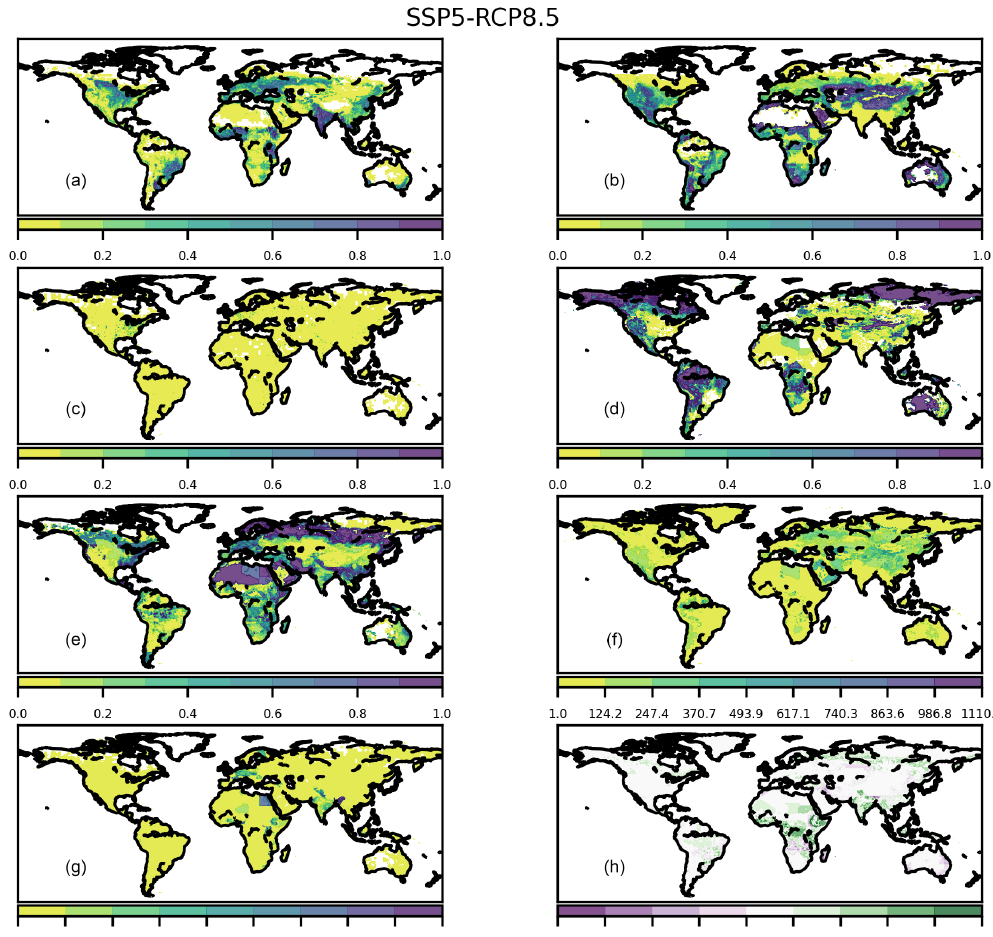
Figure 11. Maps for the year 2100 for the SSP5-RCP8.5 scenario showing the following: (a) the fraction of each grid cell occupied by cropland; (b) the fraction of each grid cell occupied by pasture; (c) the fraction of each grid cell occupied by urban land; (d) the fraction of each grid cell occupied by primary vegetation; (e) the fraction of each grid cell occupied by secondary vegetation; (f) the mean age (in years) of secondary lands in each half-degree grid cell; (g) the mean gross transitions (km 2 yr − 1 ) over a 20-year interval for each grid cell; and (h) the mean net transitions (km 2 yr − 1 ) over a 20-year interval for each grid